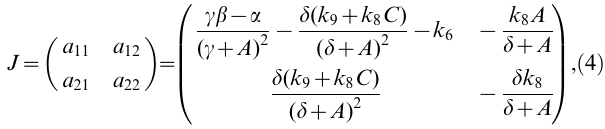
Figure S2 Amplitude and period histograms of the stochastic simulation of A . A, B. Amplitude and period histograms of the stochastic simulation of A , respectively. The values of the parameters are as in the section Methods: Biochemical reactions and rates but now we set k 4 ~ 1000 hour { 1 , k 5 ~ 5000 k 9 ~ 1 molecules hour { 1 . ( A and B were calculated for 1,000 successive cycles. We assumed that a cycle occurs if the number of proteins A increases to 1,000 molecules and then decreases to 700 molecules. The amplitude was calculated as the greatest number of A molecules in each cycle. The period was calculated as the time interval that it takes the numbers of proteins A to reach 1,000 molecules for the first time in two successive cycles.) Figure S3 Bifurcation diagram of the reduced model. A. Bifurcation diagram depending on k 9 . The solid/dashed line represents stable/unstable fixed points. Black/white circles are the maximum and minimum values of A during unstable/stable oscillations. HB denotes a Hopf Bifurcation point. HB 1 and HB 2 appear when the value of k 9 is 4.78 and 217.6 molecules hour { 1 , respectively. B. Period of the stable oscillations in A . Figure S4 Oscillatory regions in the reduced and stochastic models depending on k 8 and k 9 . Region I. Oscillations in reduced model. Region II. Oscillations in both reduced and stochastic model. Region III. Oscillations in the stochastic model. Region IV. No oscillations in any model. White circles represent the locus of Hopf bifurcations in the reduced model (data are presented in Table S2). Black circles represent locus of oscillations in the stochastic simulation (data are presented in Table S3). We assumed in the stochastic case that oscillations occur in a region if the correlation in the first period is greater than 0.2. (The lines connecting circles are designed to clearly single out the different regions.) Figure S5 Rate of the negative interaction for different values of k 11 . Rate of the negative interaction ( u ~ k 8 C ) for different values of k 11 , where k 11 is the rate of reaction C w . Deterministic simulations A, B, C, D, E, F and G correspond to k 11 equals 0.0, 0.1, 0.2, 0.3, 0.4, 0.5 and 0.6 hour { 1 , respectively. The values of the other parameters are as in the section Methods: Biochemical reactions and rates . The oscillations stop when k 11 ~ 0.6 hour { 1 ( G ). If k 11 is increased, u increases slower, and its maximum value ( u max ) is lower. The value of u max corresponds